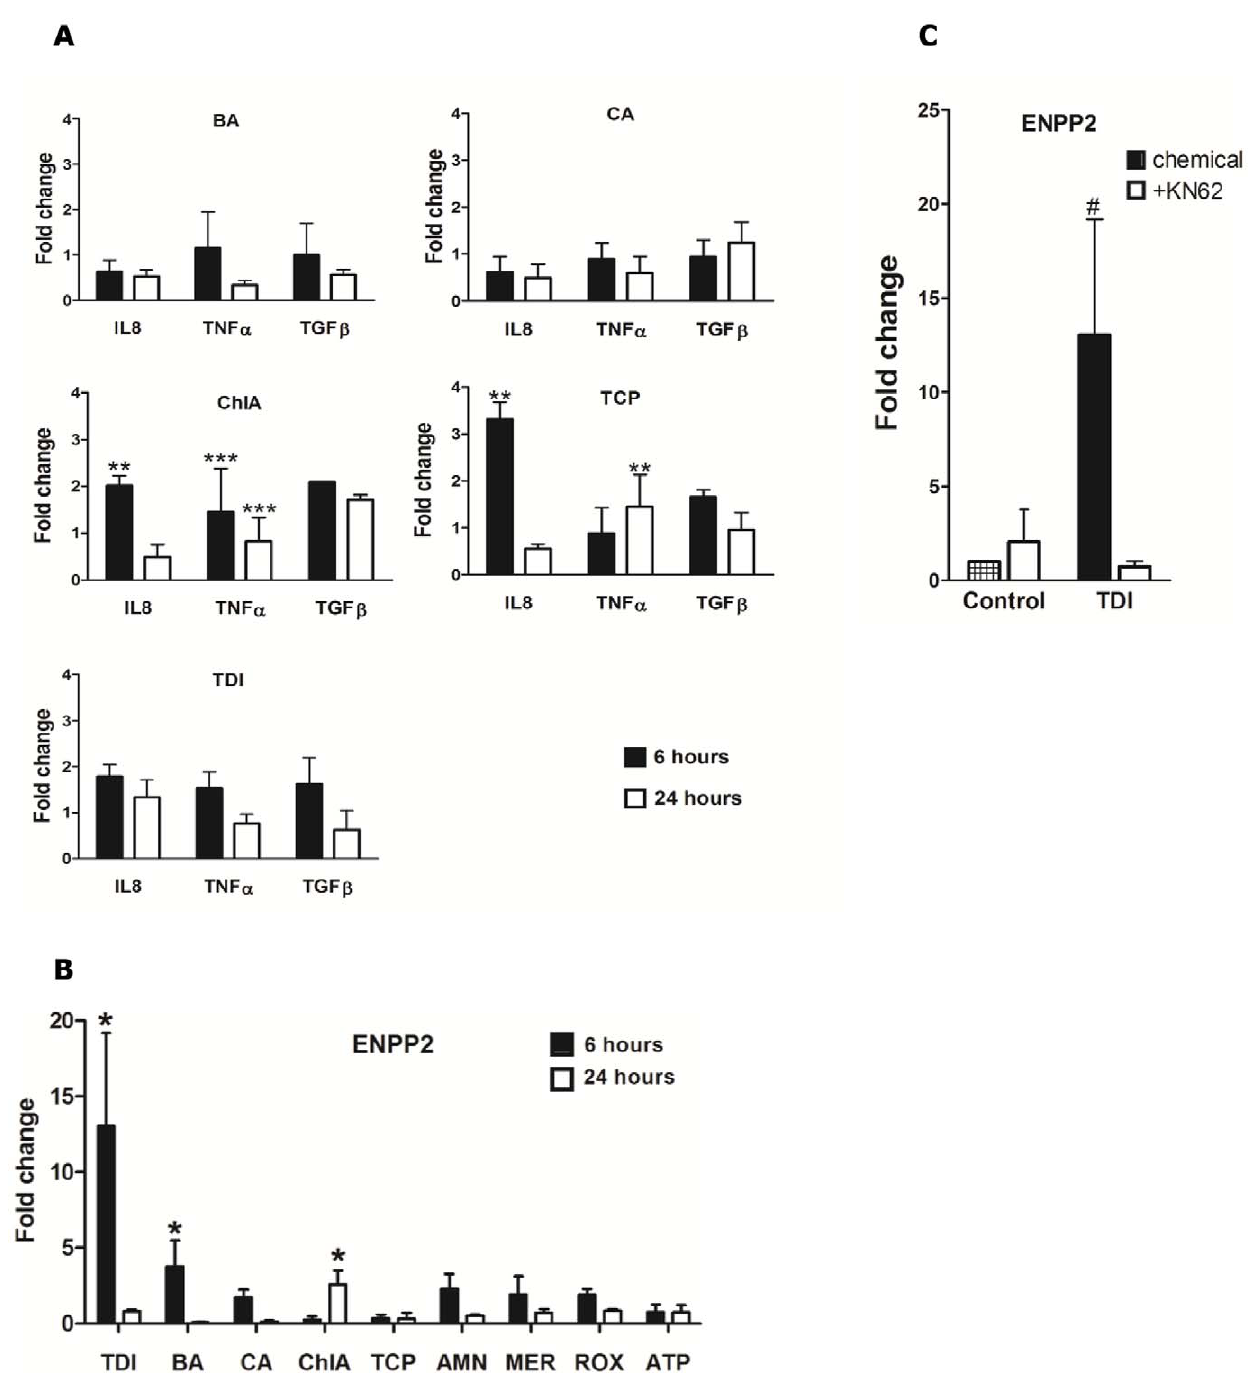
Figure 3. Male-specific carcinogens induce increased expression of inflammatory markers in Panc-1 cells. ( A ) Cells were treated with 10 m M BA, CA, ChlA, TCP or TDI for 6 or 24 hours. Samples were analyzed by Real Time RT-PCR using primers shown in Table 2. Results are presented as mean 6 SD, n=3 and control levels were set to one. ( B ) Cells were treated with 10 m M TDI, BA, CA, ChlA, TCP, AMN, MER, ROX or ATP for 6 or 24 hours. Samples were analyzed by Real Time RT-PCR using primers for ENPP2 shown in Table 2 ( C ) mRNA levels for ENPP2 in cells treated with 10 m M TDI for 6 hours in presence or absence of 100 nM KN62 (10 min pretreatment) detected by Real Time RT-PCR. Results are presented as mean 6 SD, n=3. *significantly different from controls (*p , 0.05, **p , 0.01, ***p , 0.001, #